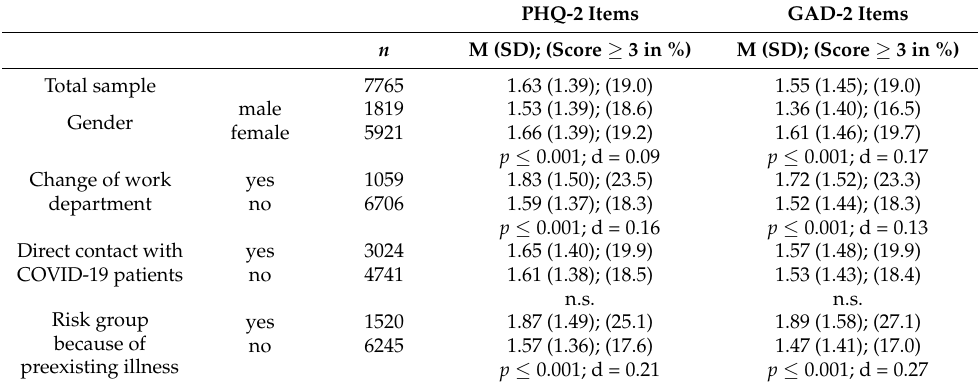
Table 3. Depression and anxiety symptoms among the sample of healthcare